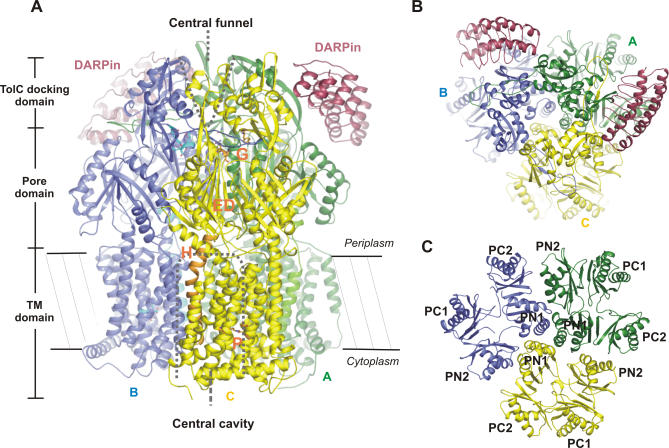
Crystal Structure of the AcrB–DARPin Complex(A) Ribbon diagram of the overall AcrB–DARPin complex structure viewed from the side, depicted in three different colors for each subunit: green, blue, and yellow for A, B, and C, respectively. The DARPins are colored in red. This color code is used throughout all the figures. The locations of the three prominent domains are indicated and the important regions are highlighted and labeled in subunit C (G, gate; ED, external depression; P, putative proton translocation site; H, helix 8).(B) Ribbon diagram of the overall AcrB–DARPin complex viewed from the periplasm.(C) Ribbon diagram of the pore domain viewed as in (B). The subdomains are labeled.All figures of the molecular models were generated with PyMOL [31].